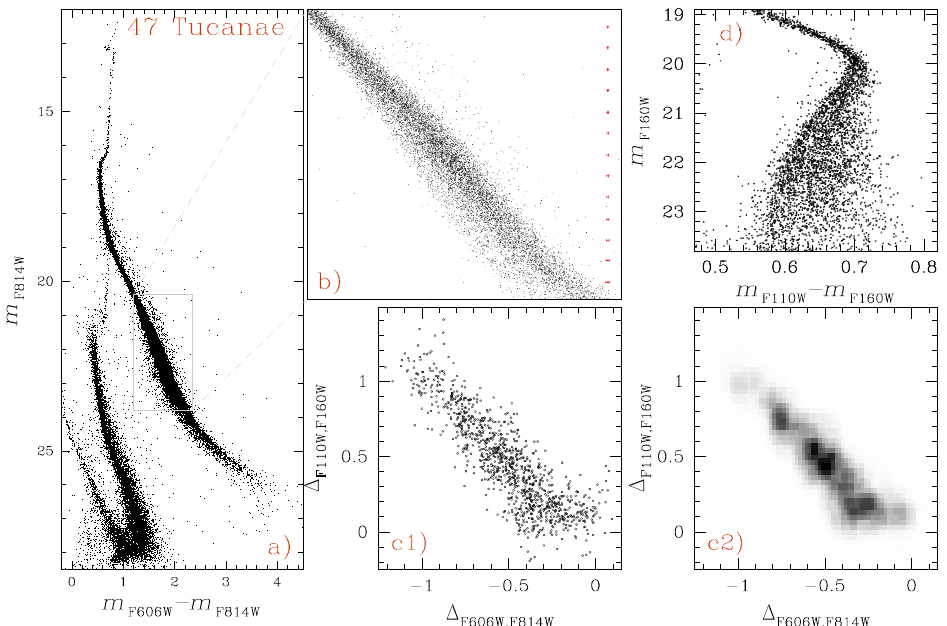
Figure 2. Collection of photometric diagrams that highlight the multiple populations among M dwarfs in 47Tucanae. Panel ( a ) shows the optical m F814W vs. m F606W − m F814W CMD, whereas panel ( b ) is a zoom around the MS region where multiple sequences are more evident. Panels ( c1 , c2 ) represent the ChM of M dwarfs and the corresponding Hess diagrams, respectively. The NIR m F814W vs. m F606W − m F814W CMD is plotted in panel ( d ). To prepare this figure we used the photometric catalogs by Milone et al. [23,61] and Dondoglio et al.